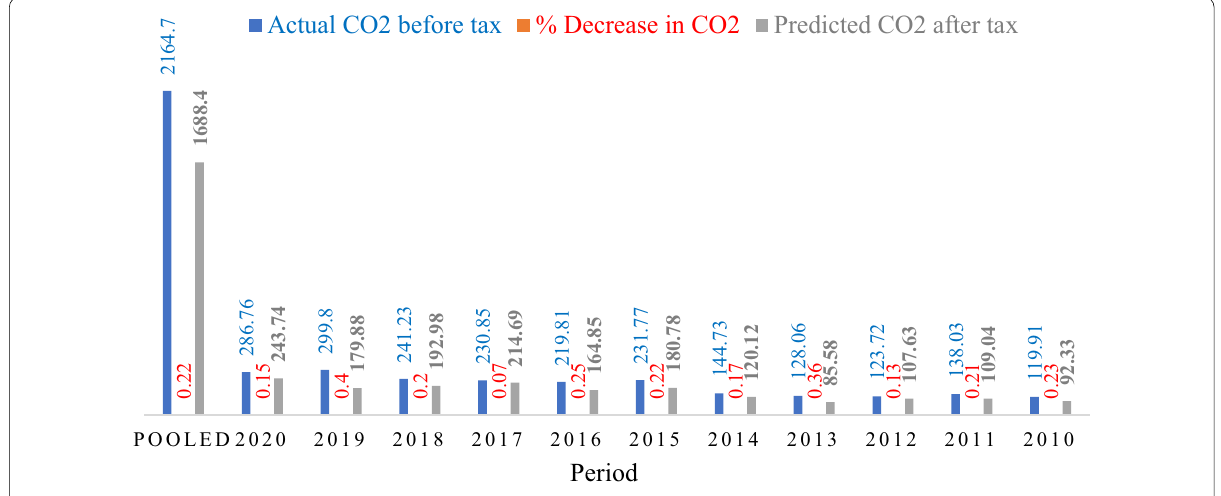
Fig. 12 Percentage reduction in CO 2 emissions under carbon tax (5%) emissions reduction